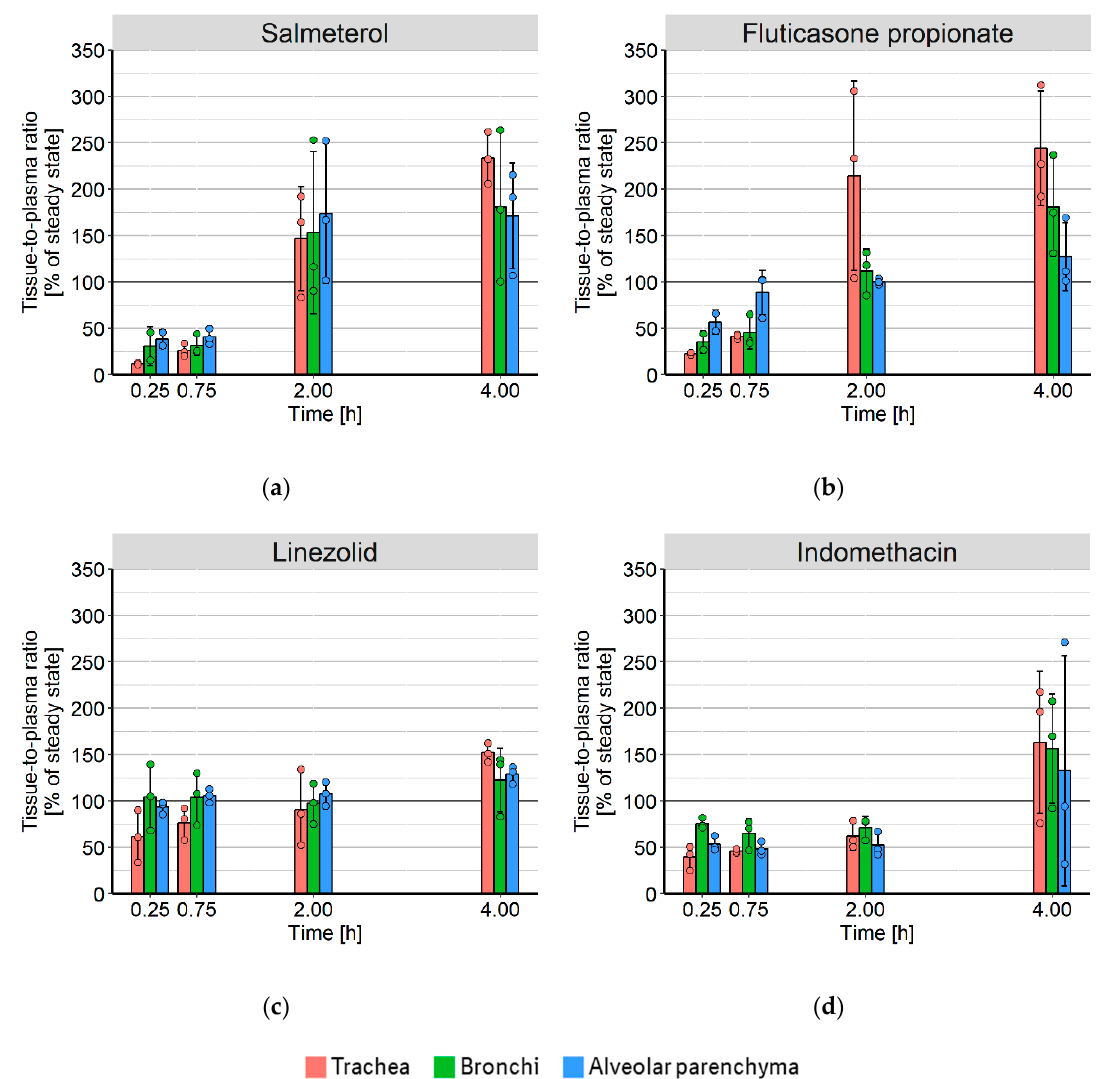
Figure 5. Observed tissue-to-plasma concentration ratios in the trachea (red), bronchi (green), and alveolar parenchyma (blue) as a percentage of steady state (the model estimate of K p ) for ( a ) salmeterol, ( b ) fluticasone propionate, ( c ) linezolid, and ( d ) indomethacin. The bars represent the mean value including the standard deviation, the filled circles represent the individual data points.